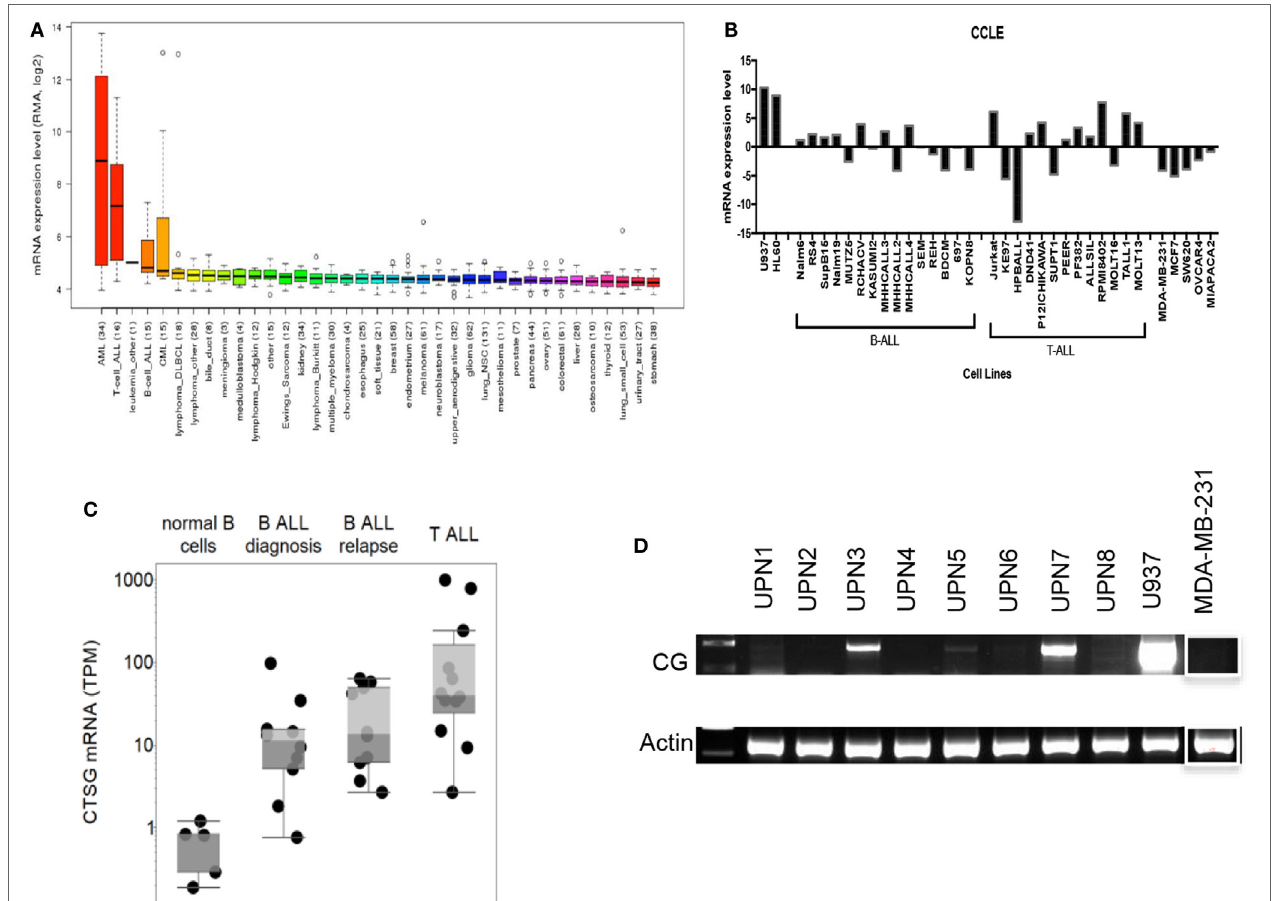
FigUre 1 | Cathepsin G (CG) transcript is detected in B-ALL patient samples and cell lines. (a) According to Cancer Cell Line Encyclopedia (CCLE), ALL cell lines express CG transcript at higher levels compared with other malignancies. High-expressing acute myeloid leukemia (AML) cell lines are shown for comparison. (B) CG mRNA expression is not ubiquitous to all ALL. CG levels are lower in B-ALL and T-ALL cell lines compared with U937 and HL60 AML cell lines, but are higher compared with solid tumors; MDA-MB-231 (breast cancer), MCF7 (breast cancer), SW620 (colorectal adenocarcinoma), OVCAR-3 (ovarian adenocarcinoma), and MIA PaCa-2 (pancreatic carcinoma). (c) The Cancer Genome Atlas shows higher CG expression at the transcript level in B-ALL compared to normal B cells. Additionally, mRNA expression is higher in relapsed B-ALL compared with B-ALL at time of diagnosis. T-ALL has the highest CG expression at the transcript